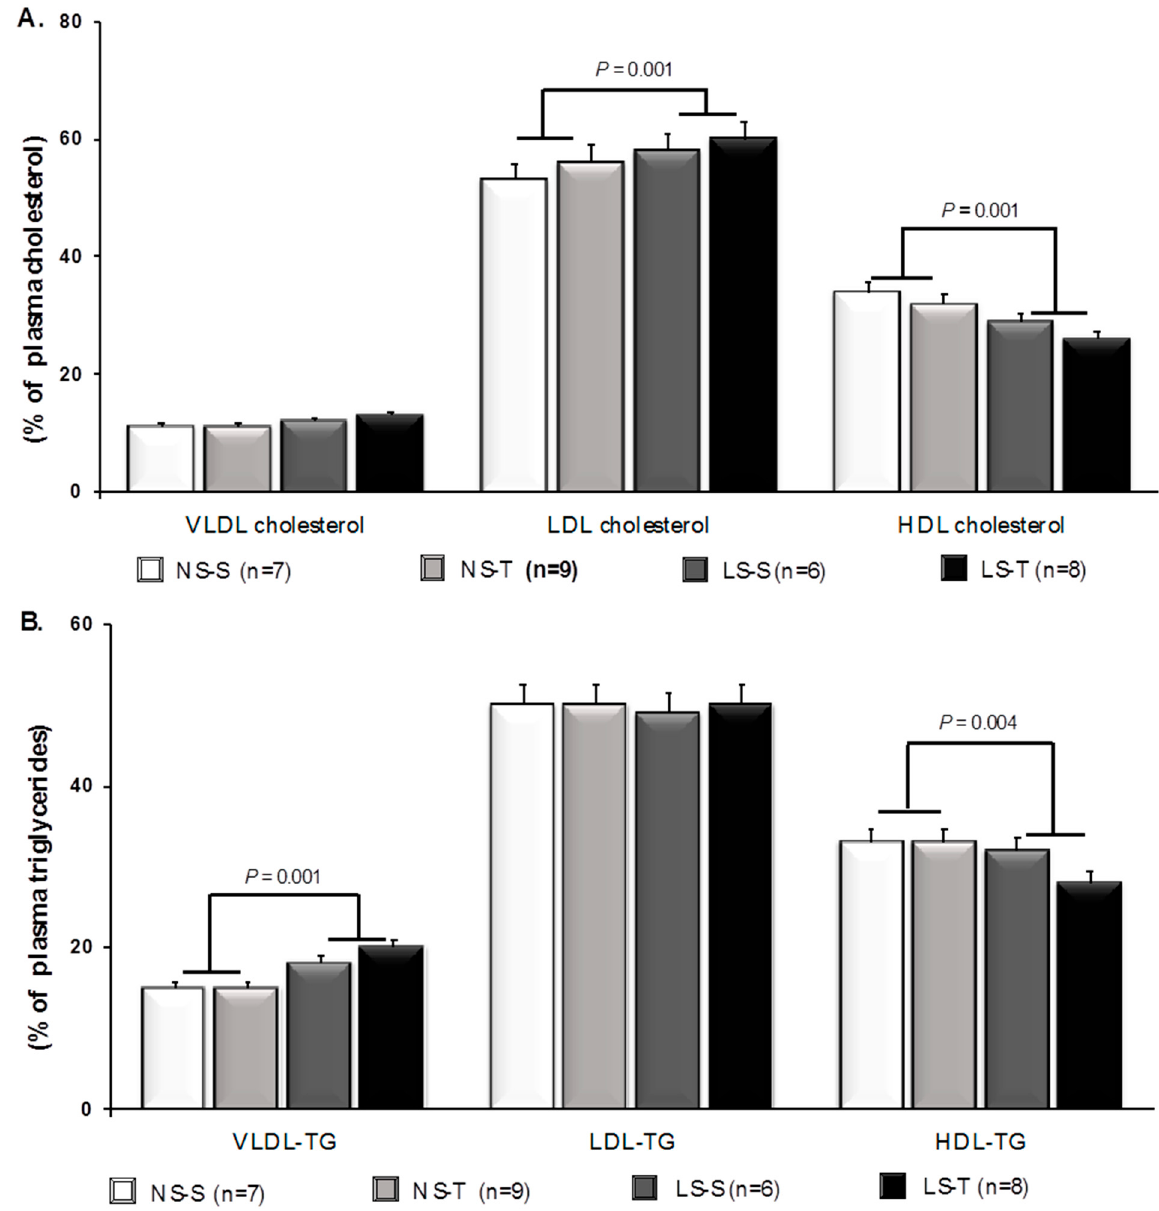
Figure 1. Percent of plasma lipids in lipoproteins by fast protein liquid chromatography (FPLC) in LDLR KO mice fed either a normal-sodium (NS) or a low-sodium (LS) diet, trained (T) or sedentary (S), after 90 days. ( A ) Percent of cholesterol in lipoprotein fractions. ( B ) Percent of triglycerides